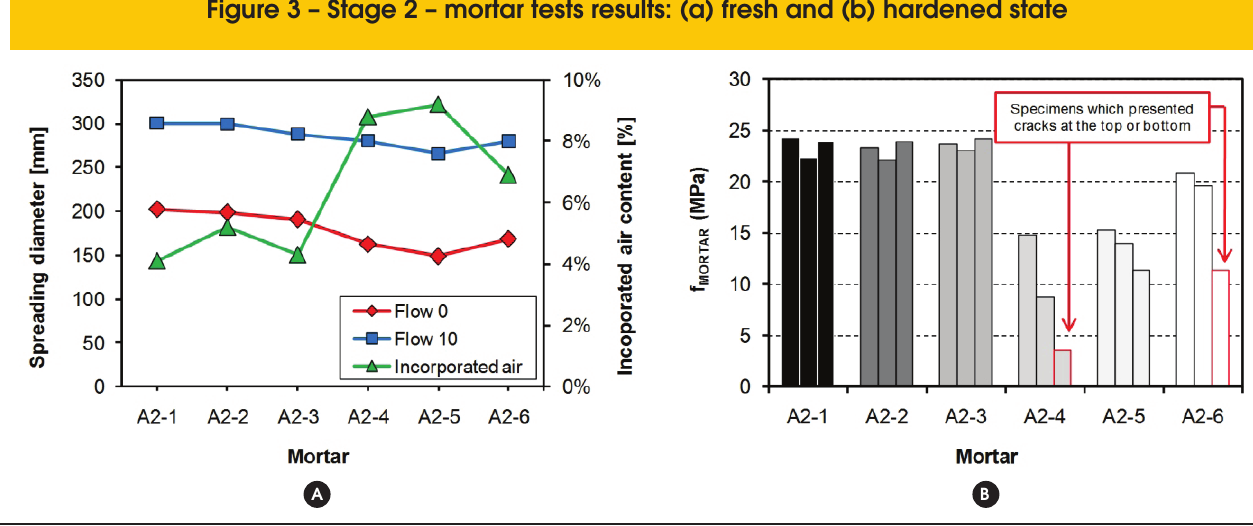
Figure 3 – Stage 2 – mortar tests results: (a) fresh and (b) hardened